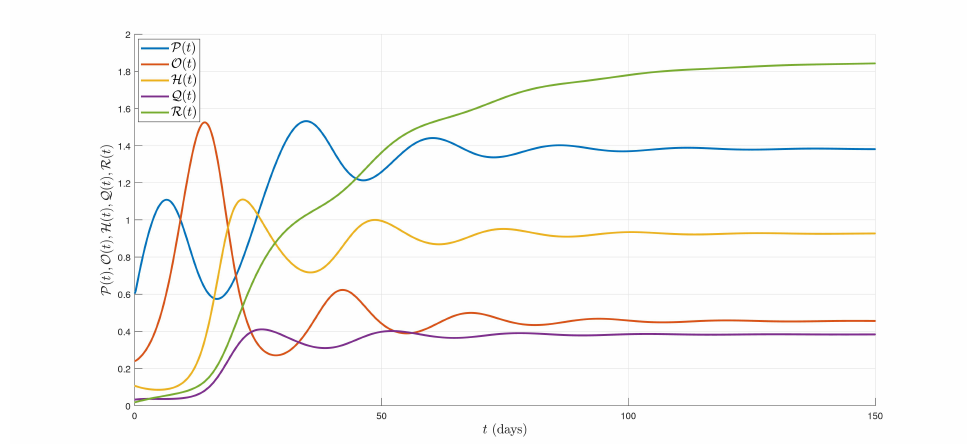
Figure 2. Behaviors of five sub-classes under fractal-fractional order κ 1 = κ 2 = 1.00.